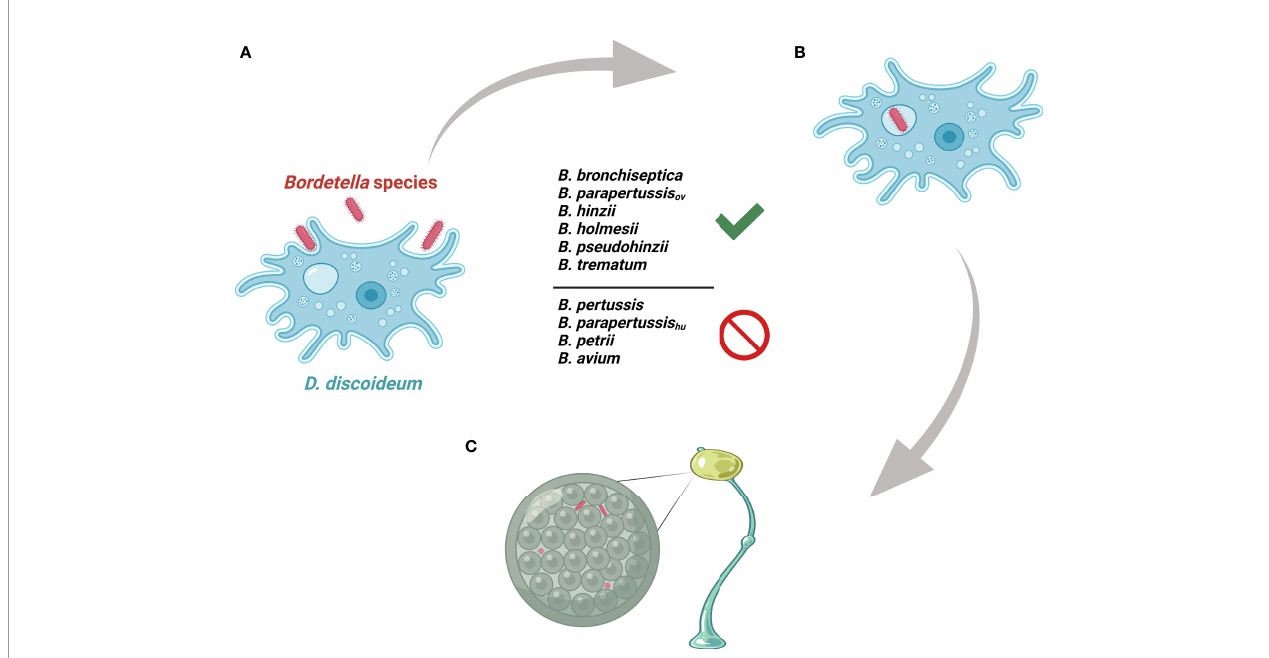
FIGURE 7 | Illustration of Bordetella -amoebal interactions. (A) D. discoideum predates on Bordetella species. (B) Some Bordetella species resist phagocytosis of D. discoideum . (C) Some Bordetella species translocate to fruiting